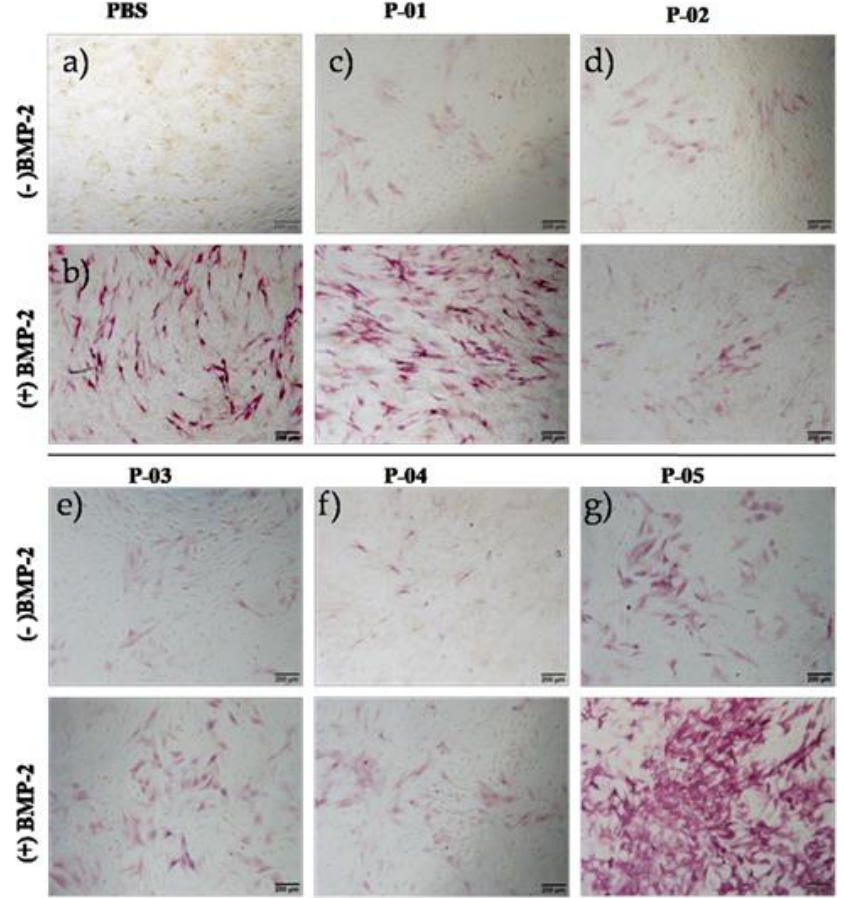
Figure 3. Alkaline phosphatase (ALP) staining in C2C12 cells (3 × 104 cells/well) cultured for six days in a 24-well plate, with peptides alone at a concentration of 500 nM. (- BMP) without BMP-2 protein; (+BMP-2) with BMP-2 protein; ( a ) Control with PBS; ( b ) BMP-2 protein 2.5 nM; ( c ) P-01; ( d ) P-02; ( e ) P-03; ( f ) P-04 ( g ) P-05.